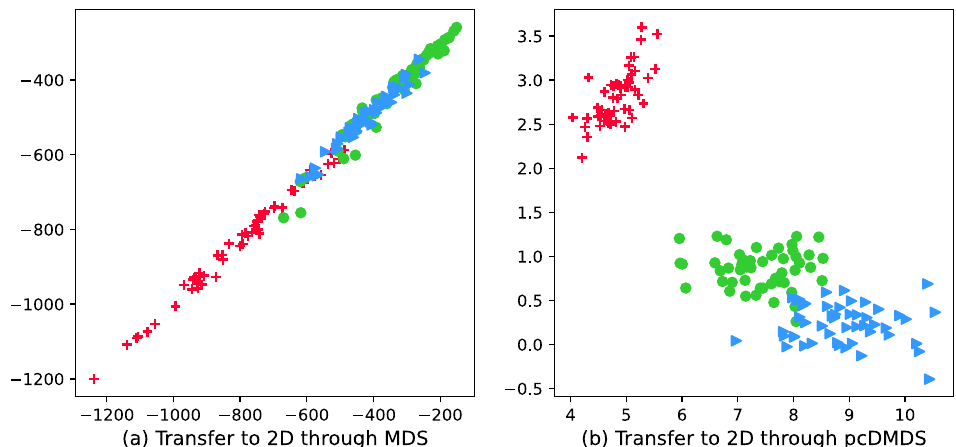
Figure 2. Visualization of wine dataset after dimensionality reduction using MDS and pcDMDS.